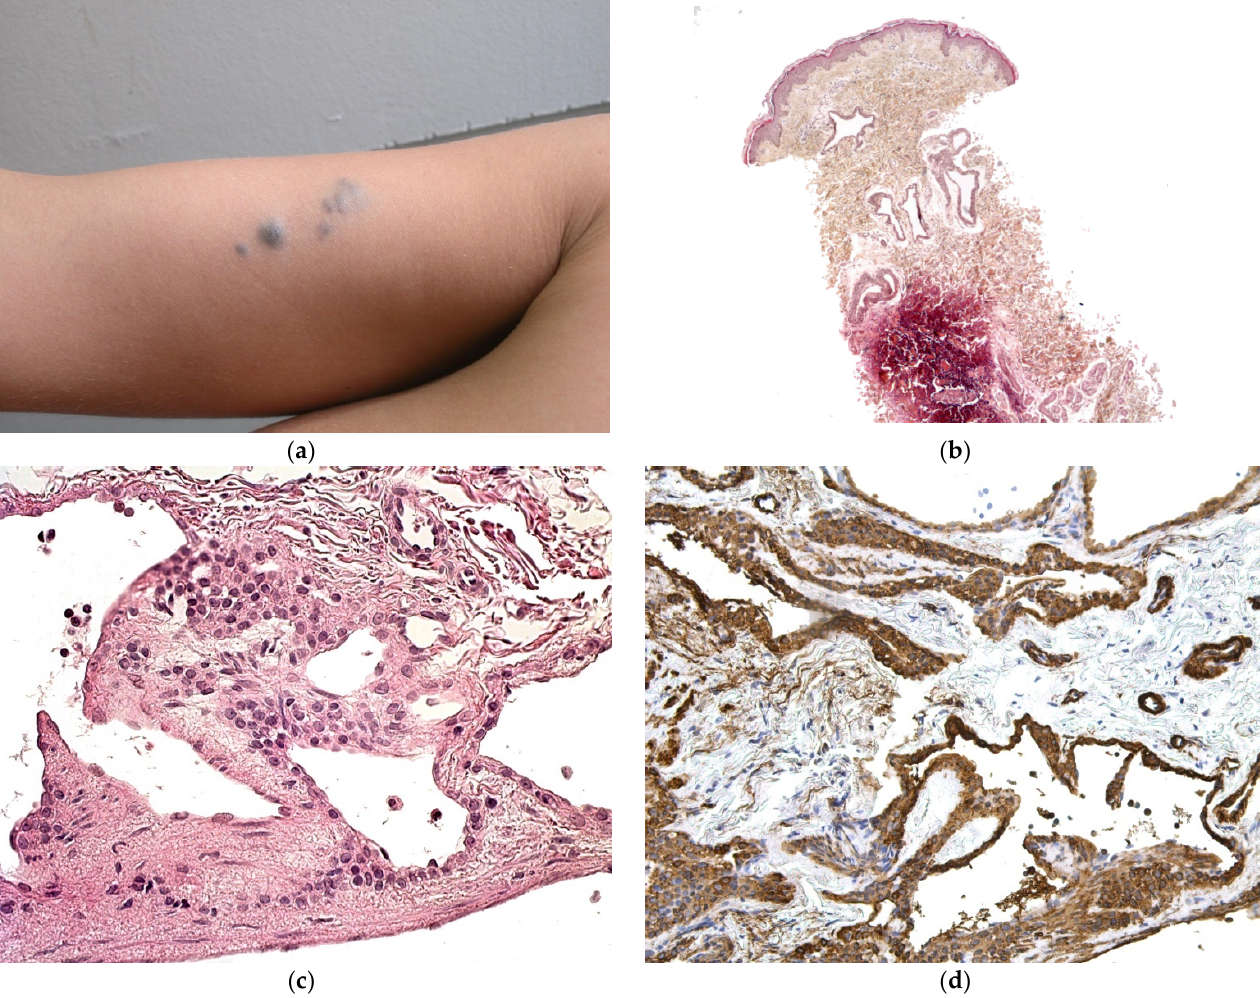
Figure 16. Glomuvenous malformation. ( a ) Bluish to violet small nodules in the arm. ( b ) 10× multiples veinous channels in the dermis. ( c ) 25× these vessels are surrounded by round glomus cells. ( d ) These cells are highlighted by anti-SMA.